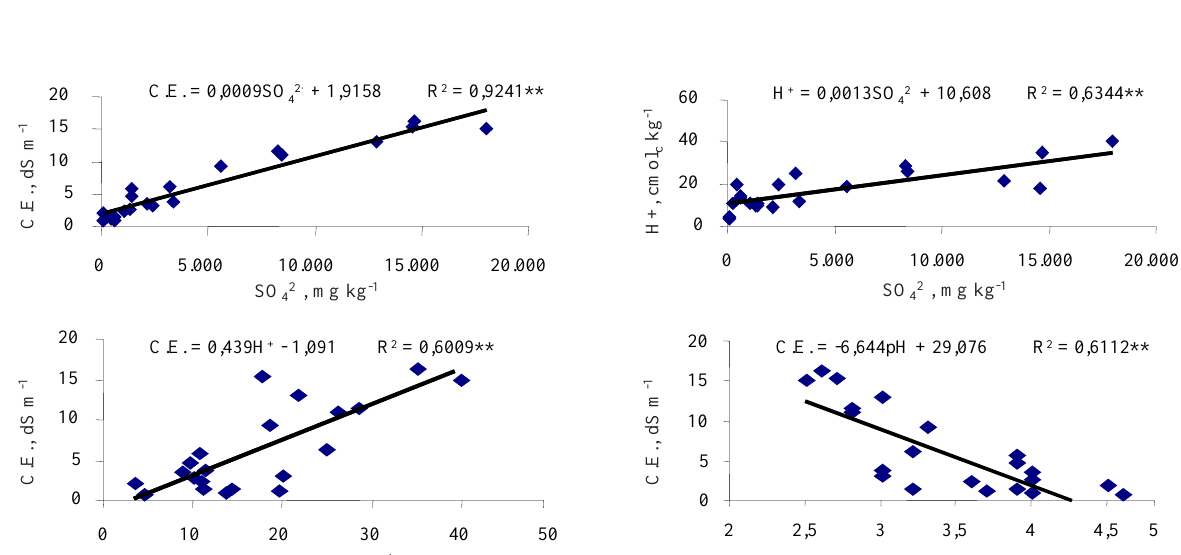
Figura 3. Correlações entre: sulfato solúvel e condutividade elétrica (a), sulfato solúvel e hidrogênio trocável (b), hidrogênio trocável e condutividade elétrica e pH e condutividade eletrica (d) em solos tiomórficos da várzea do rio Coruripe